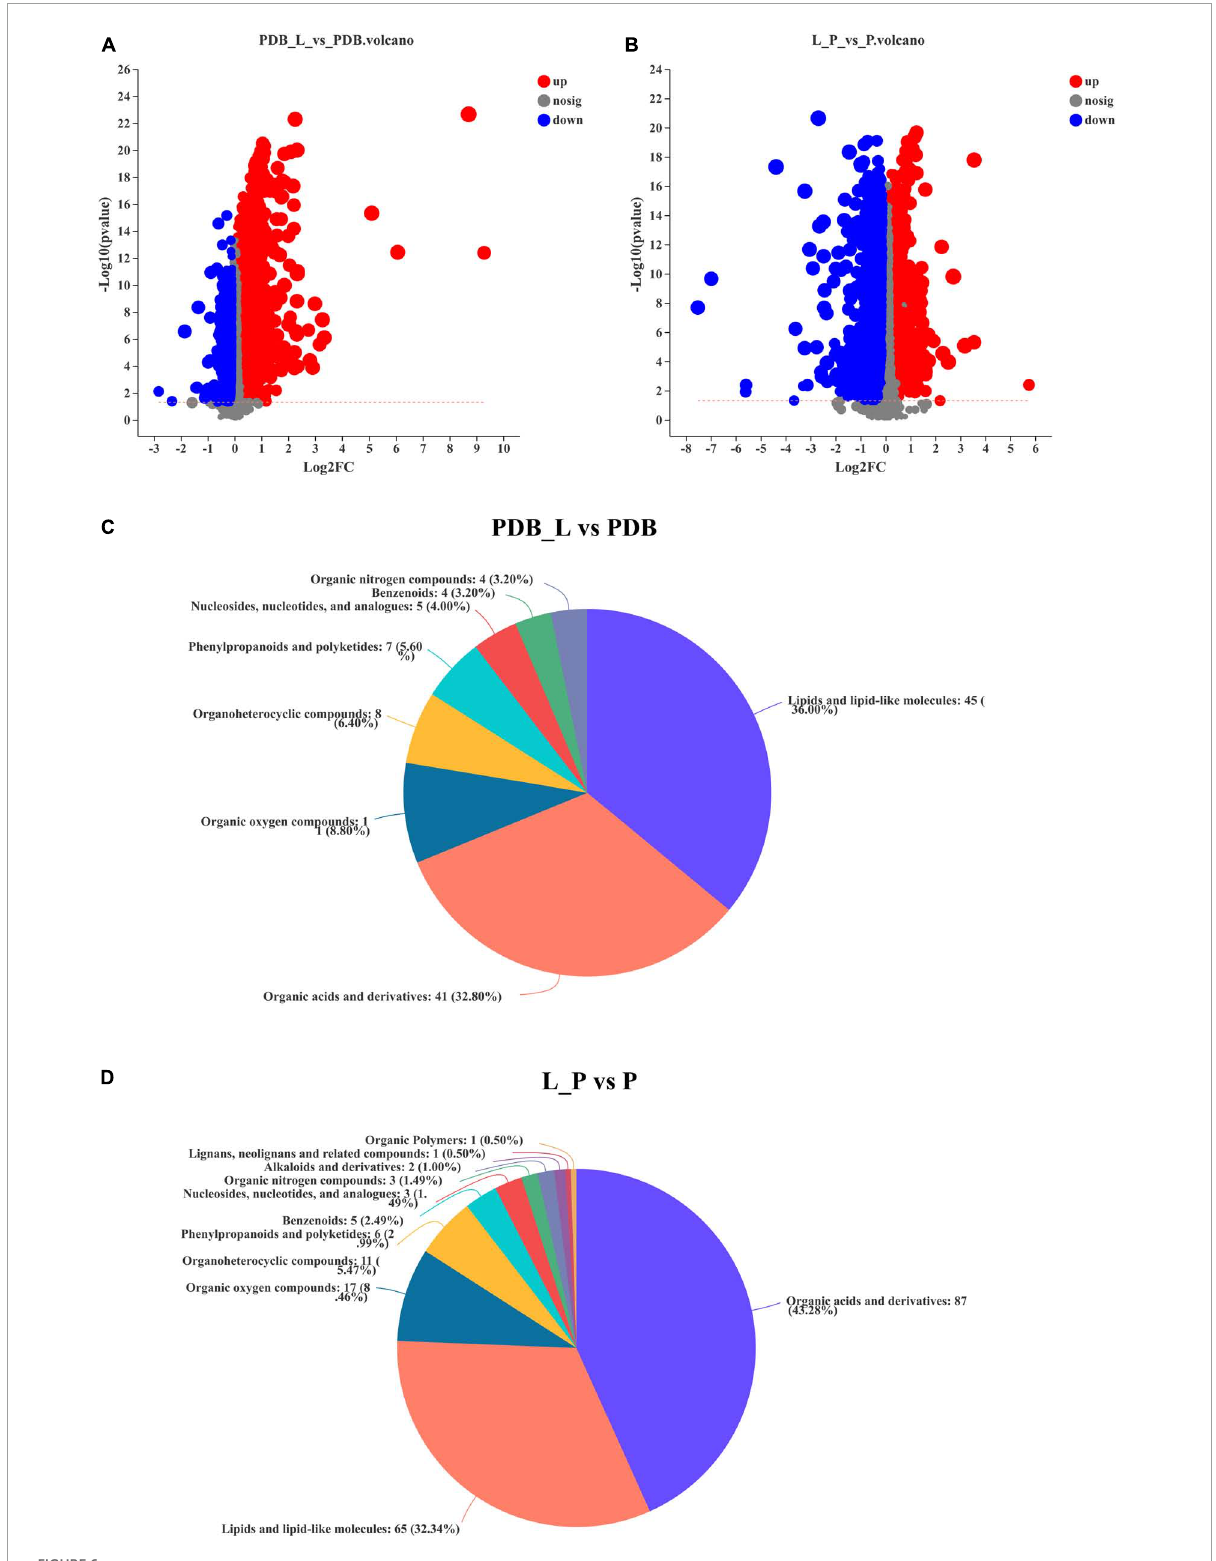
FIGURE6 Volcano plot of differential metabolites and classification of the Human Metabolome Database (HMDB) compounds. (A,C) PDB_L vs. PDB groups; (B,D) L_P vs. P groups, red is up-regulation, blue is down-regulation (FC > 1.2 or < 1.2, p <